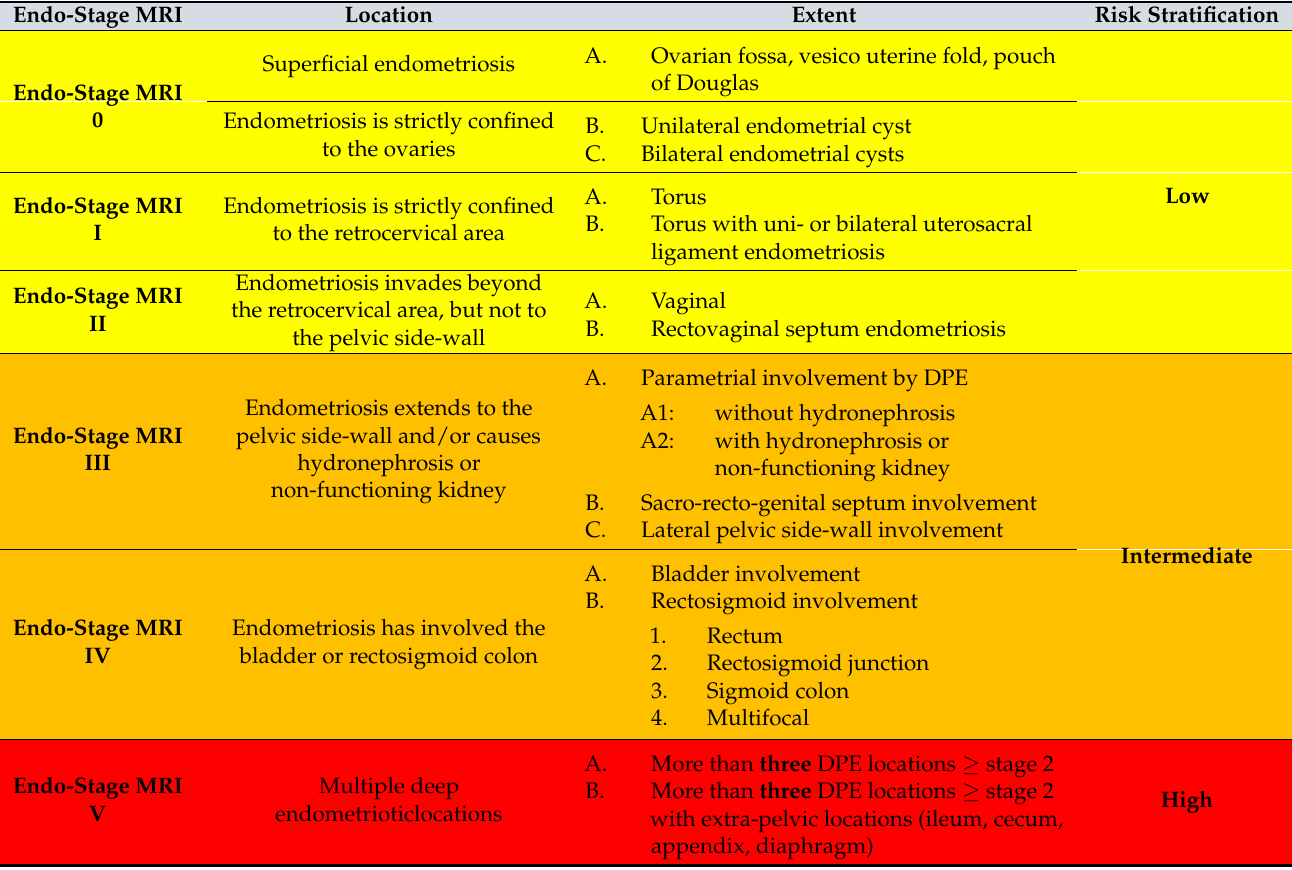
Table 2. Endo-Stage MRI